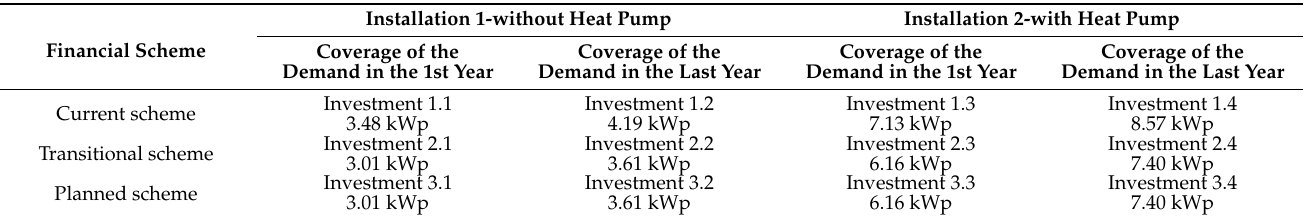
Table 3. Power of pv investments subject to profitability analysis for various installations’ options and financing